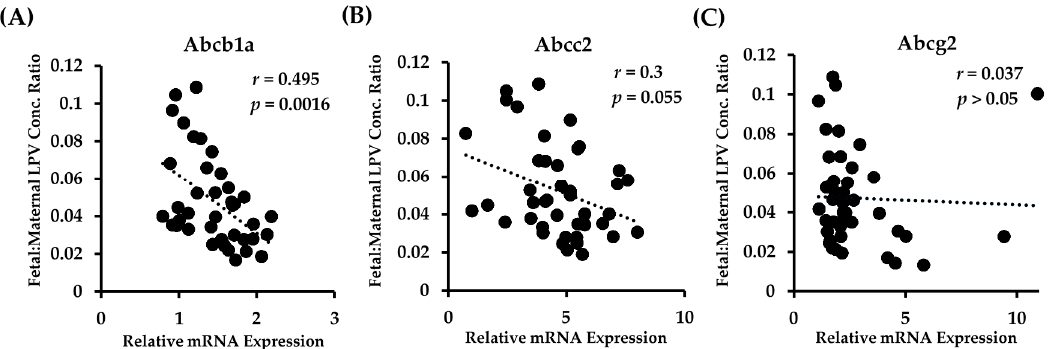
Figure 3. Relationship between fetal accumulation of LPV and placental expression of ( A ) Abcb1a; ( B ) Abcc2; and ( C ) Abcg2 in all fetal PXR genotypes. Fetal accumulation is represented as the LPV concentration of fetal homogenate (ng/g) relative to maternal plasma concentration (ng/mL). Relative placental mRNA expression was determined as described in the Materials and Methods section. n = 39.